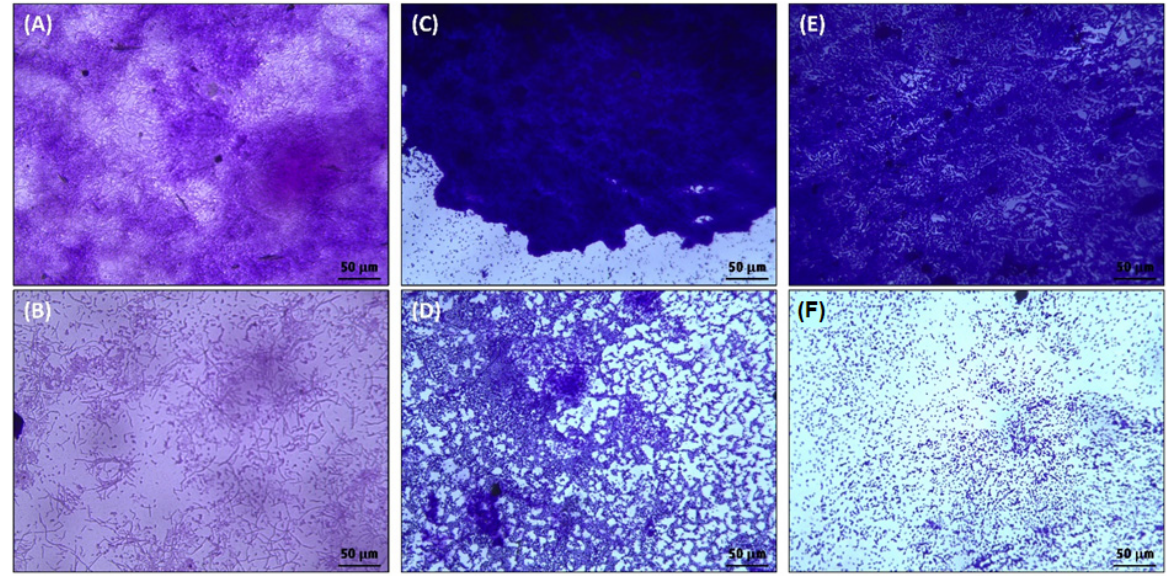
Figure 4. Light microscopic images of the E. coli , P. aeruginosa , and S. aureus biofilms in the absence and presence of ZnO-NPs. ( A ) untreated control E. coli ; ( B ) E. coli treated with ½ × MIC of ZnO-NPs; ( C ) untreated control P. aeruginosa ; ( D ) P. aeruginosa treated with ½ × MIC of ZnO-NPs; ( E ) untreated control S. aureus ; ( F ) S. aureus treated with ½ × MIC of ZnO-NPs.